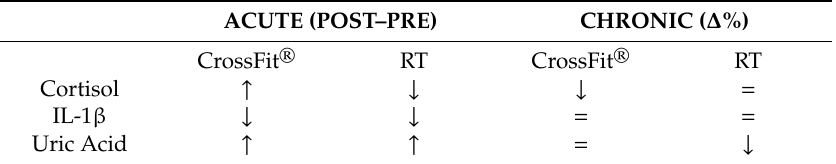
Table 3. Synopsis of the major results elicited by the two conditioning training programs. ACUTE (POST–PRE) CHRONIC ( ∆